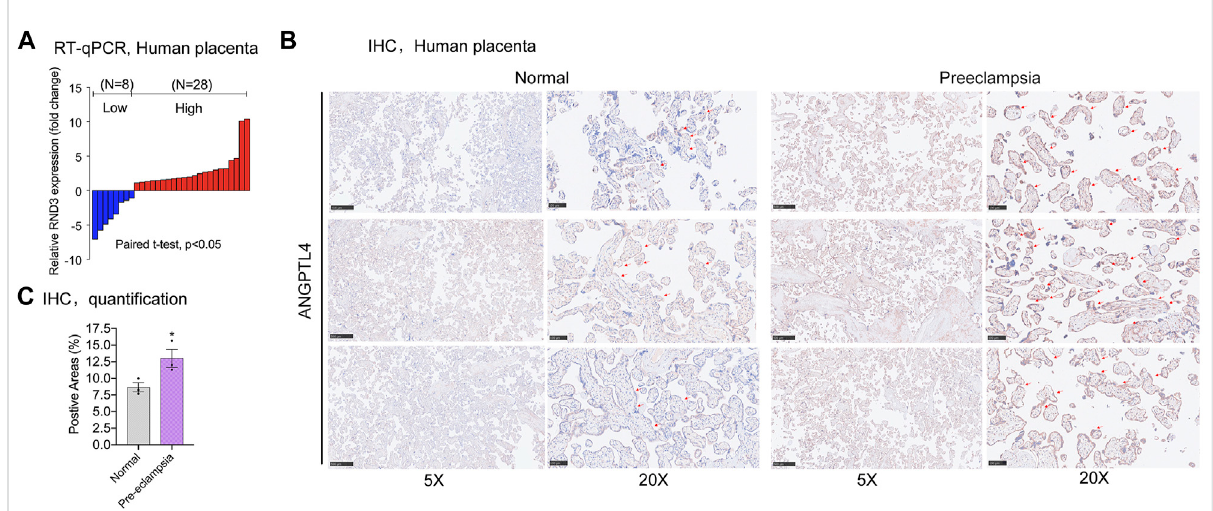
FIGURE 6 Expression of ANGPTL4 in preeclampsia placental tissues. qPCR results showed the fold change of placental tissue in PE patients compared to healthypregnantwomen( n =34) (A) .TheabundanceofANGPTL4proteinwasdetectedbyimmunohistochemistry (B) ,quanti fi cationwasperformed by positive areas (C) . All data are representative of at least three independent experiments. * p < 0.05, ** p < 0.01; signi fi cance by Student ’ s t